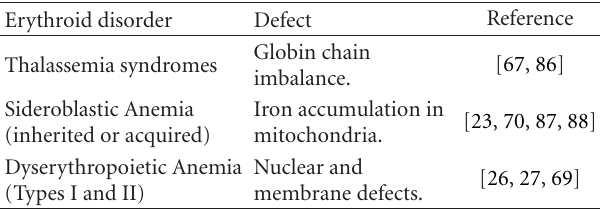
Table 1: Ine ff ective erythropoiesis associated with iron overload in absence of